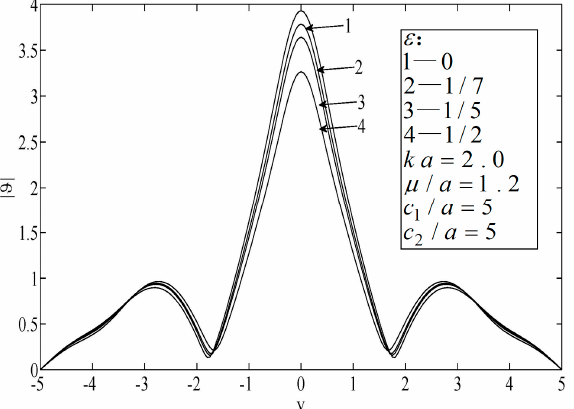
Figure 5. Temperature on the surfaces of the block.